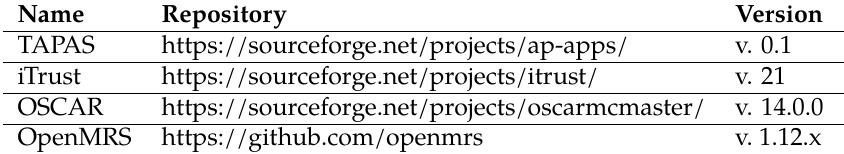
Table 2: Summary of open source health care systems chosen to analyze in this study.